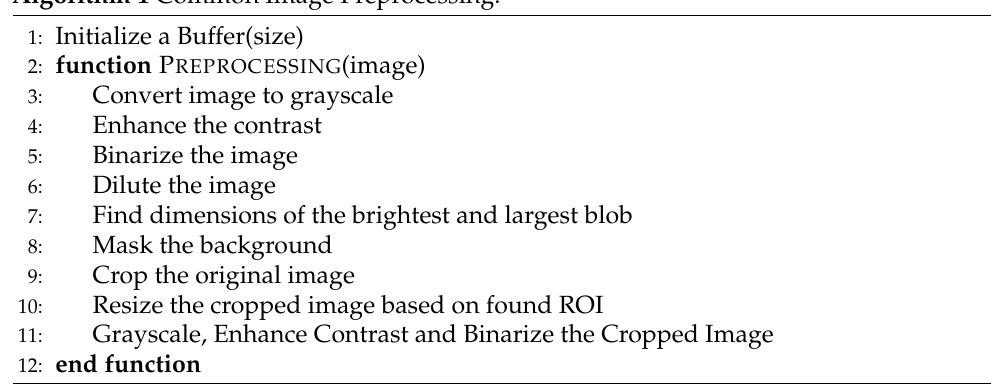
Algorithm 1 Common Image